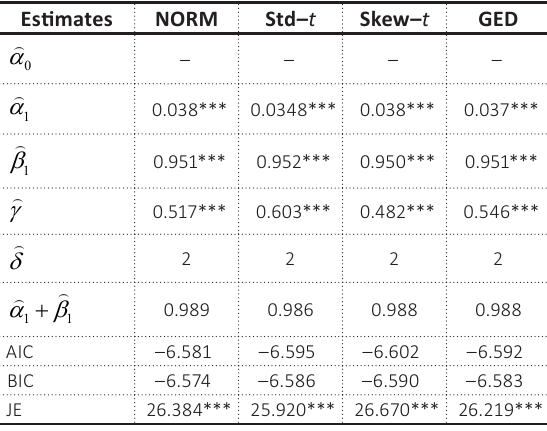
Table 4. ML parameter estimates of